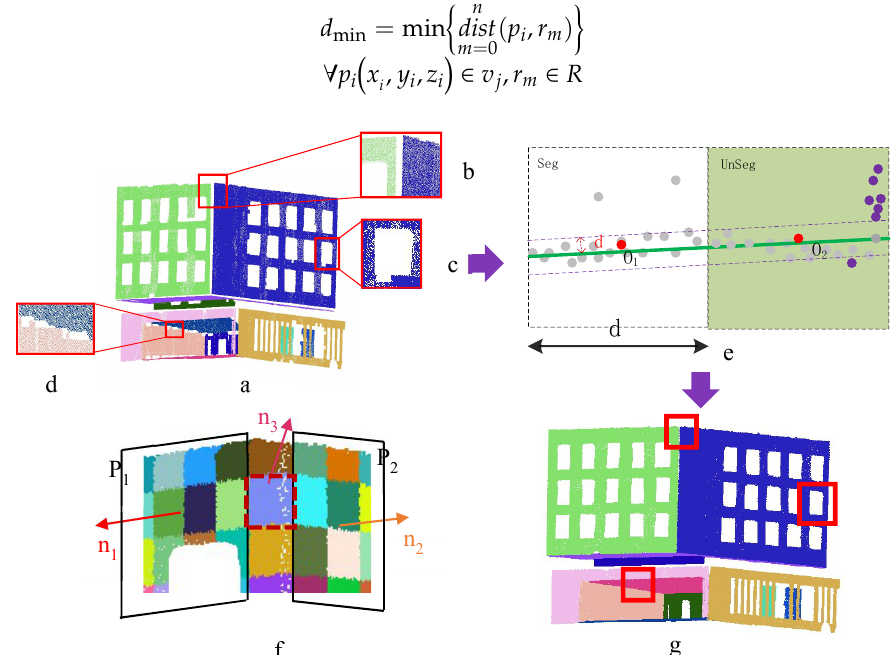
Figure 7. Process for handling under-segmentation. ( a ) Results of coarse point cloud segmentation; ( b – d ) are cases of under-segmentation, ( e ) schematic of unlabeled voxel segmentation, ( f ) a voxel at the junction of two planes cannot cluster into anyone plane, and ( g ) results of unlabeled voxel segmentation.